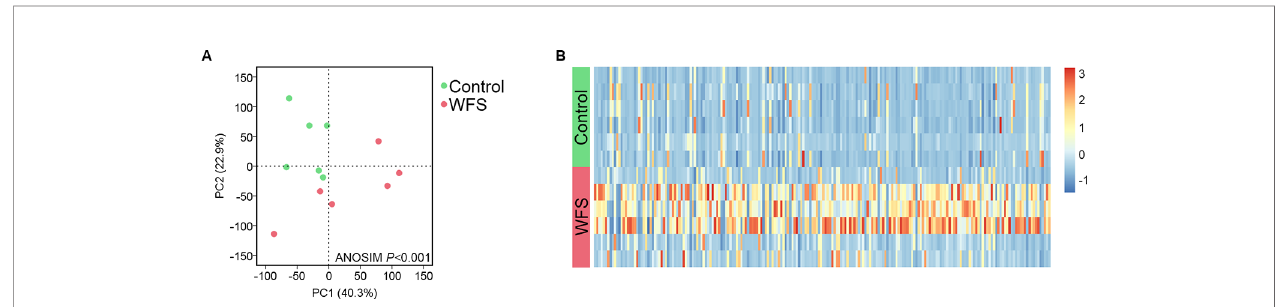
FIGURE 4 | Comparative analysis of transcript pro fi les between Control (n = 6) and white feces syndrome (WFS) (n = 6). (A) The principal coordinate analysis (PCoA) based on the expression level of all transcripts. The WFS samples were distinct from the Control samples. (B) A total of 206 transcripts were identi fi ed to be differed signi fi cantly between Control and WFS. The heatmap was conducted based on the FPKM value of each